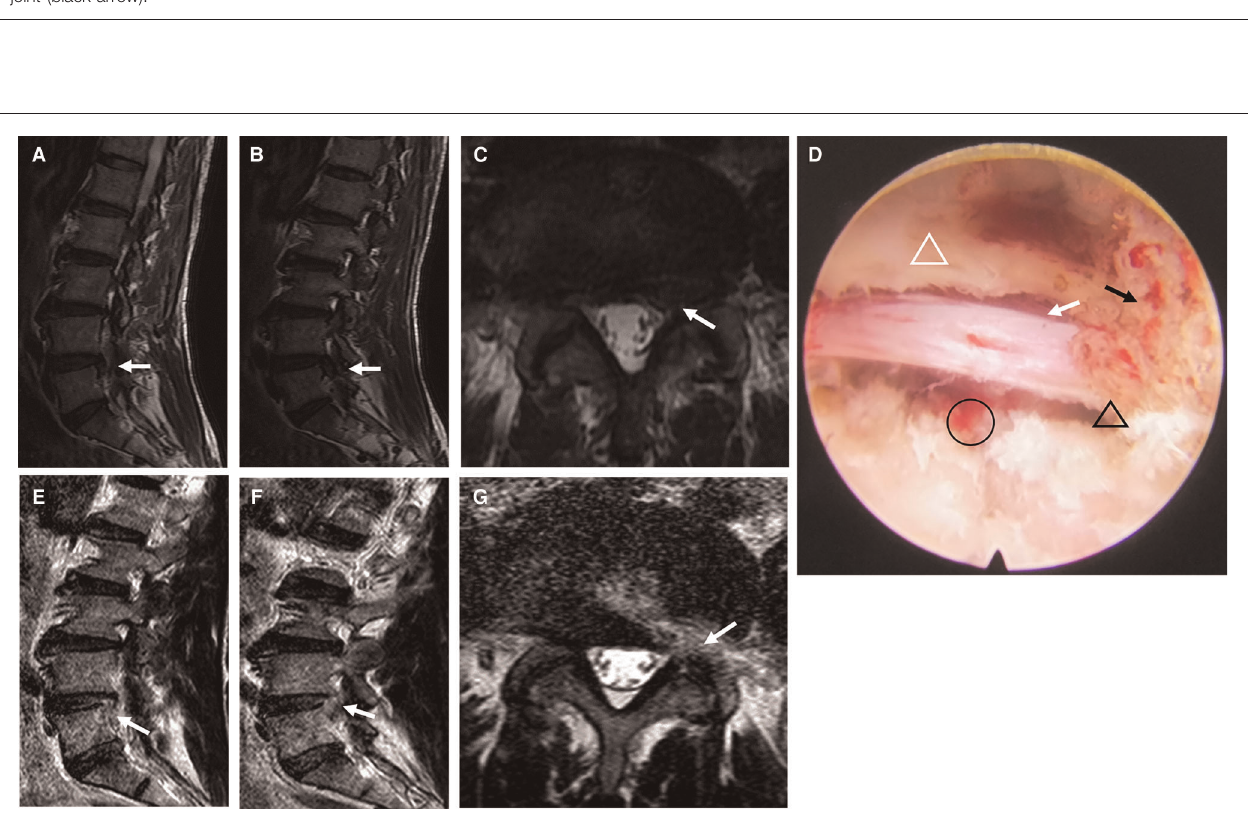
FIGURE 3 | Schematic diagram of annulus fi brosus excision and lateral recess decompression. ( A ) Excision of the hypertrophic annulus fi brosus (black arrow) and posterior longitudinal ligament (white arrow). ( B,C ) Transverse and sagittal demonstration of lateral recess decompression with partial resection of the superior facet joint (black arrow).